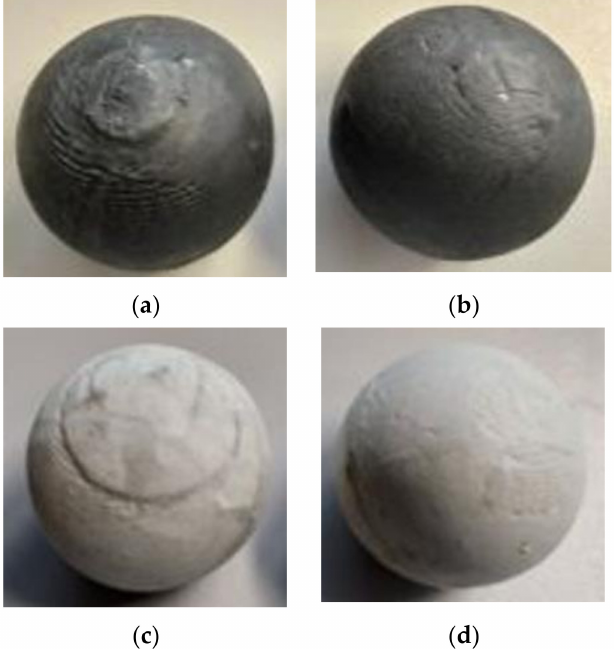
Figure 12. Comparison of balls obtained in the process of physical modelling: ( a ) I set of tolls black plasticine; ( b ) II set of tolls black plasticine; ( c ) I set of tolls white plasticine; ( d ) II set of tolls white